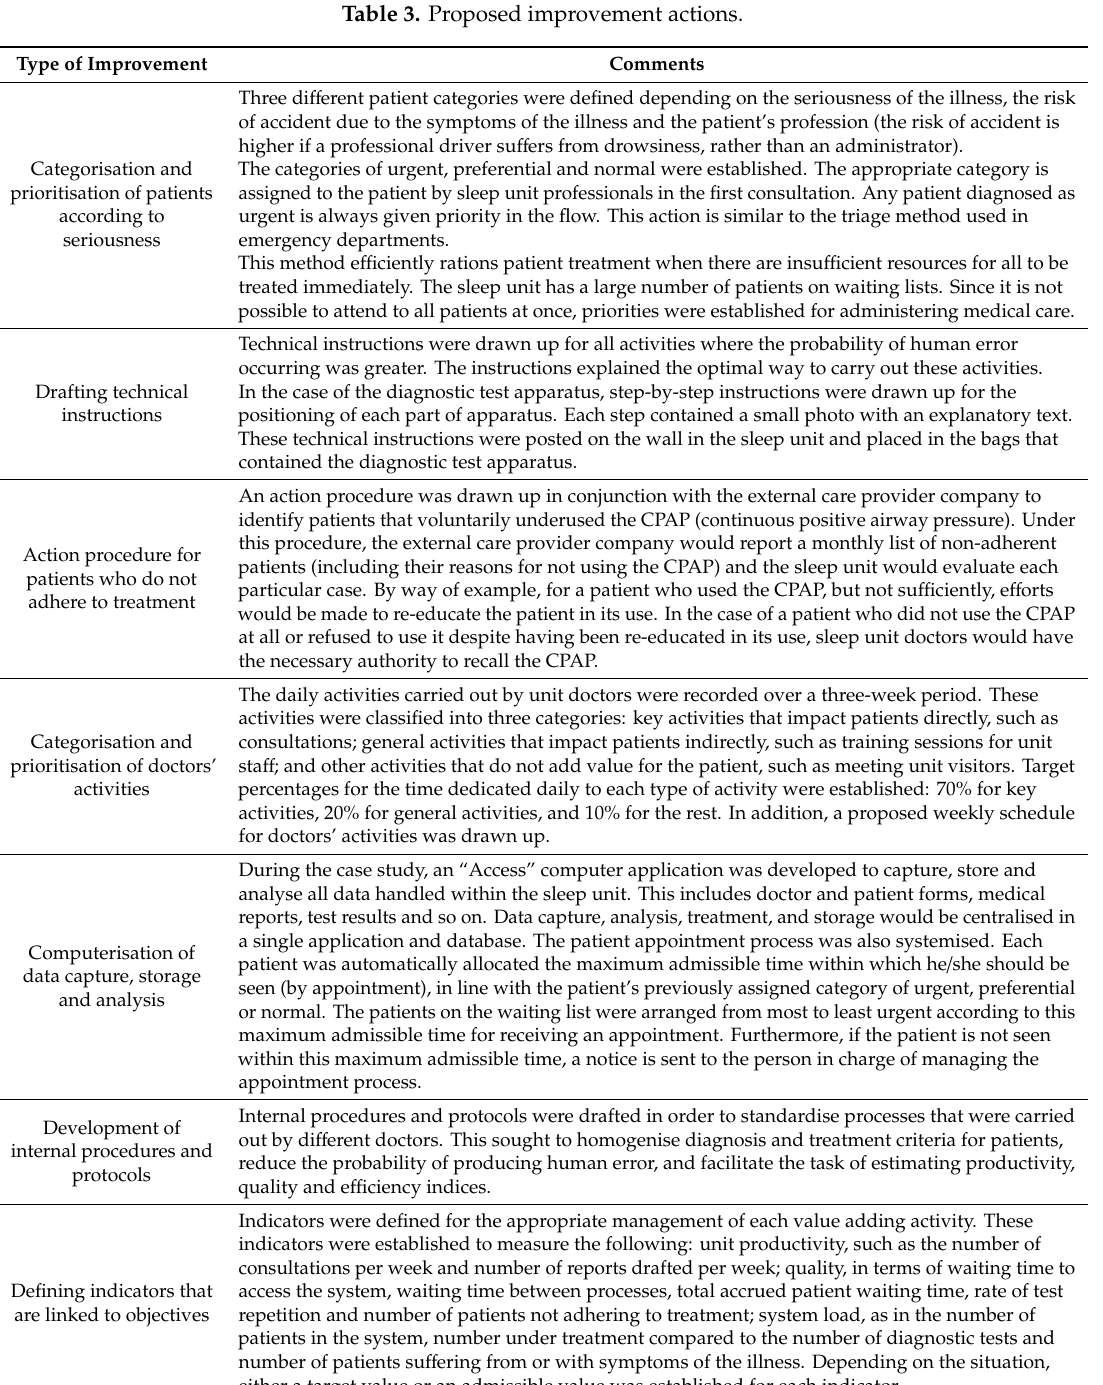
Table 3. Proposed improvement